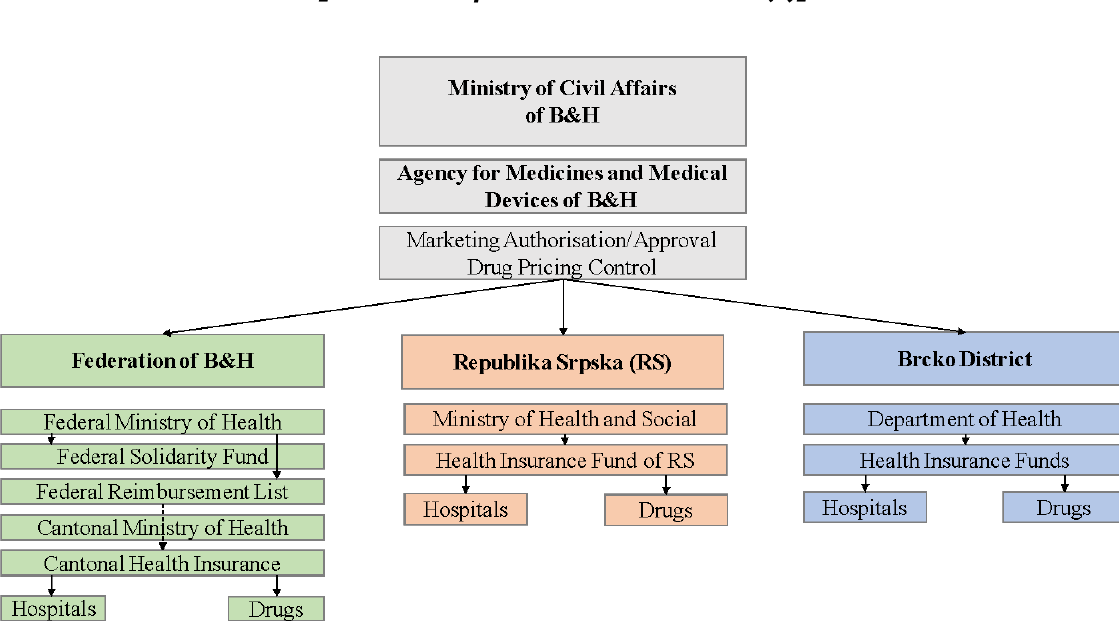
Figure 2. Main stakeholders for drug prescription in the healthcare system of B&H [Source: adapted from Guzvic et al.